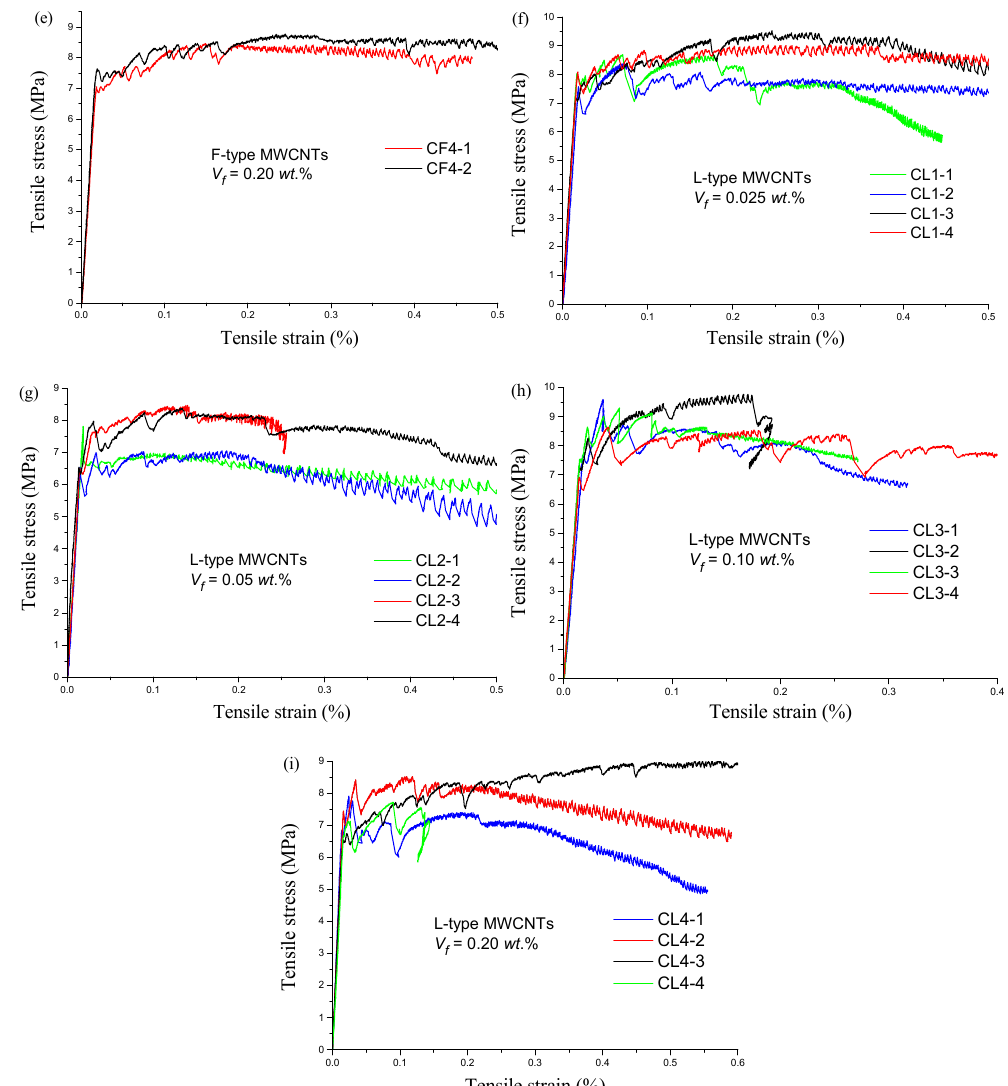
Figure 6. Uniaxial tensile stress–strain curves for each group: (a) R; (b) CF1; (c) CF2; (d) CF3; (e) CF4;